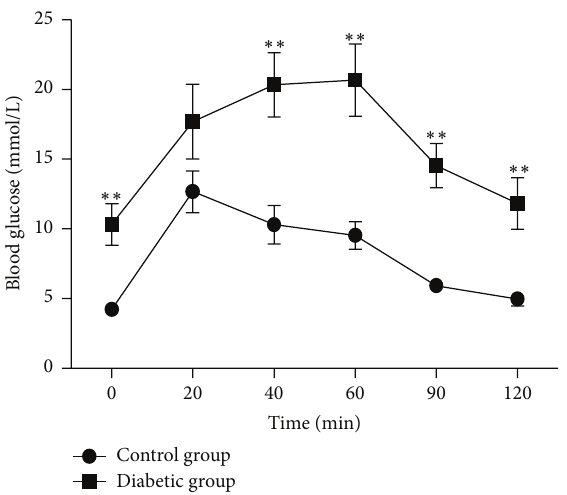
Figure 2: Oral glucose tolerance test (OGTT) in the healthy control group and diabetic group at week 5. 𝑛 = 6 in control group; 𝑛 = 5 in diabetic group. ∗∗ 𝑃 < 0.01 . Figure 3: Proportion of reads mapped to the exons, introns, and intergenic regions in liver tissues of the control and diabetic